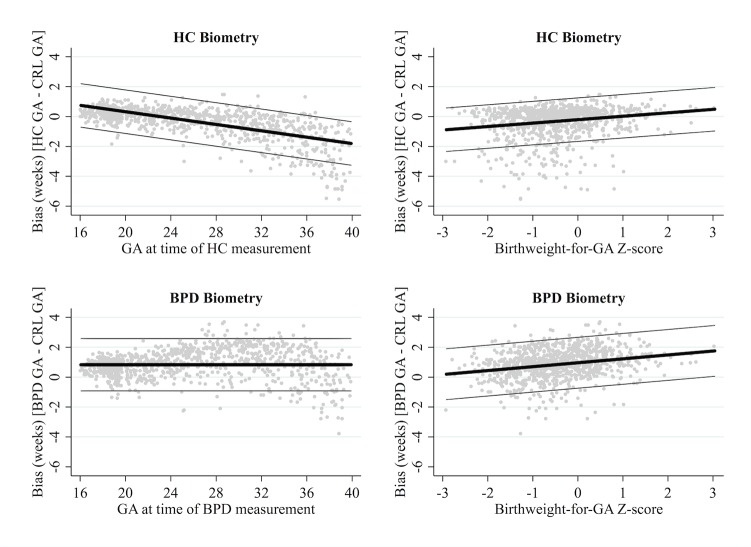
Agreement between CRL and HC or BPD biometry.Reference standard: crown-rump length (CRL) biometry. HC: head circumference. BPD: biparietal diameter. Gestation time of HC/BPD measurement determined from CRL biometry. Thick black lines represent the mean bias of HC biometry in reference to CRL biometry; the thin grey lines represent the 95% limits of agreement.